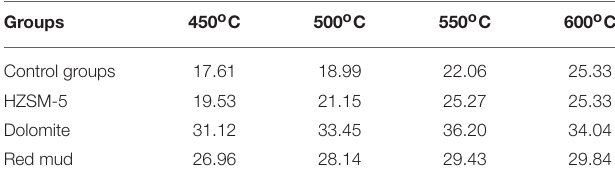
Polycyclic Aromatic Phenols Distribution TABLE 4 | The content of total phenols in